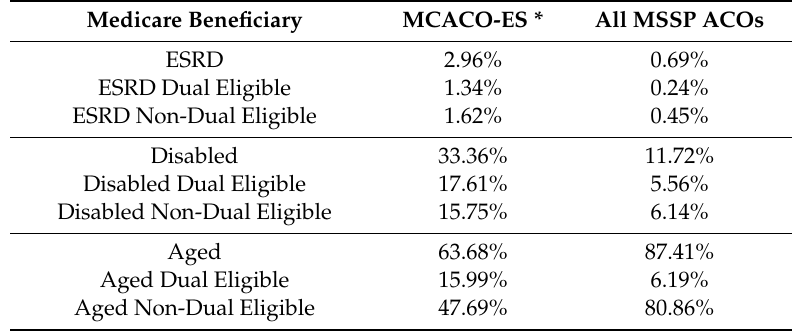
Table 2. Medicare Beneficiary Health Conditions (%) in MCACO-ES Compared to All MSSP ACOs.